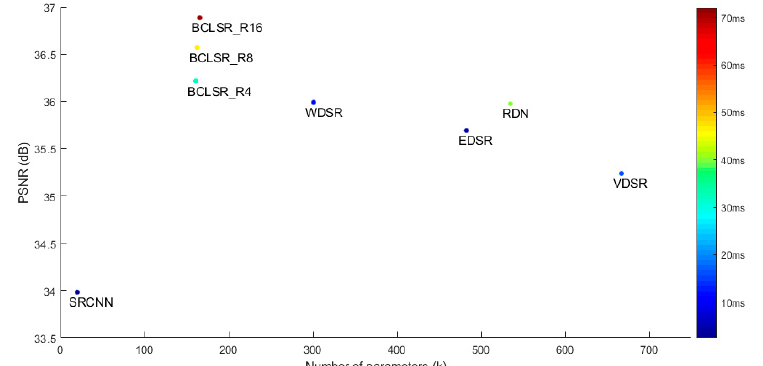
Figure 14. Comparison of the PSNR and the model size of SR methods on the COWC datasets for the scale factor ×2. The color of the point that corresponds to the bar on the right indicates the processing times with a 256 × 256 output image size on